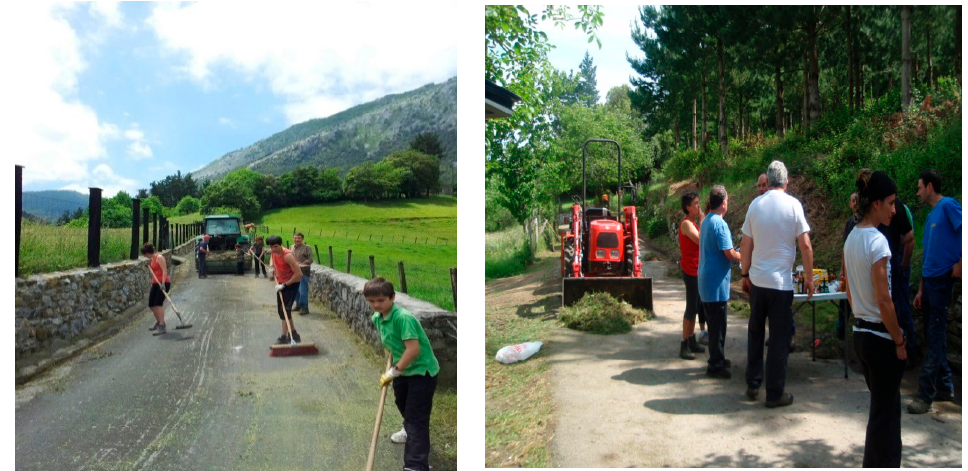
Figure 1. Neighbours in an auzolana (participatory community work). Participants or parents in the case of minors gave their consent to have their pictures